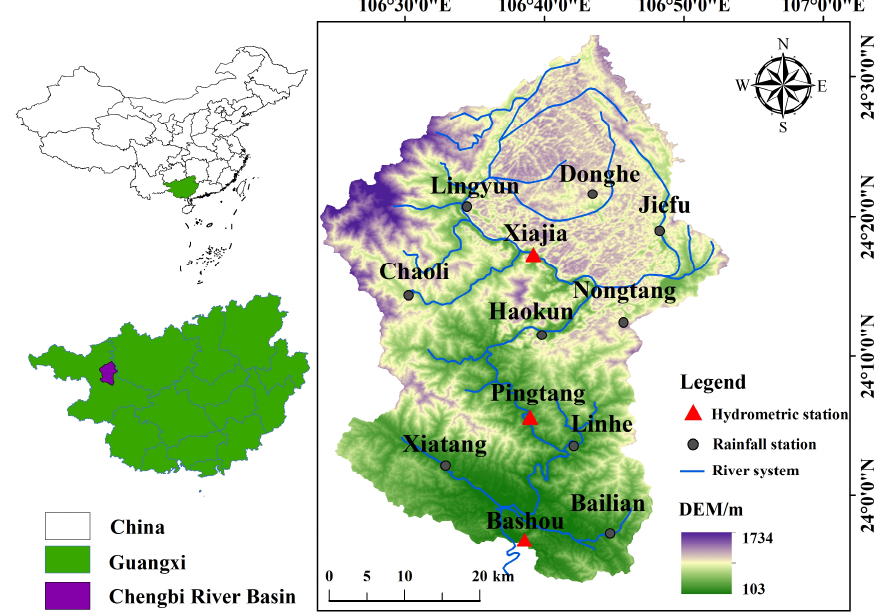
Figure 1. Location of the Chengbi River basin and distribution of the stations.